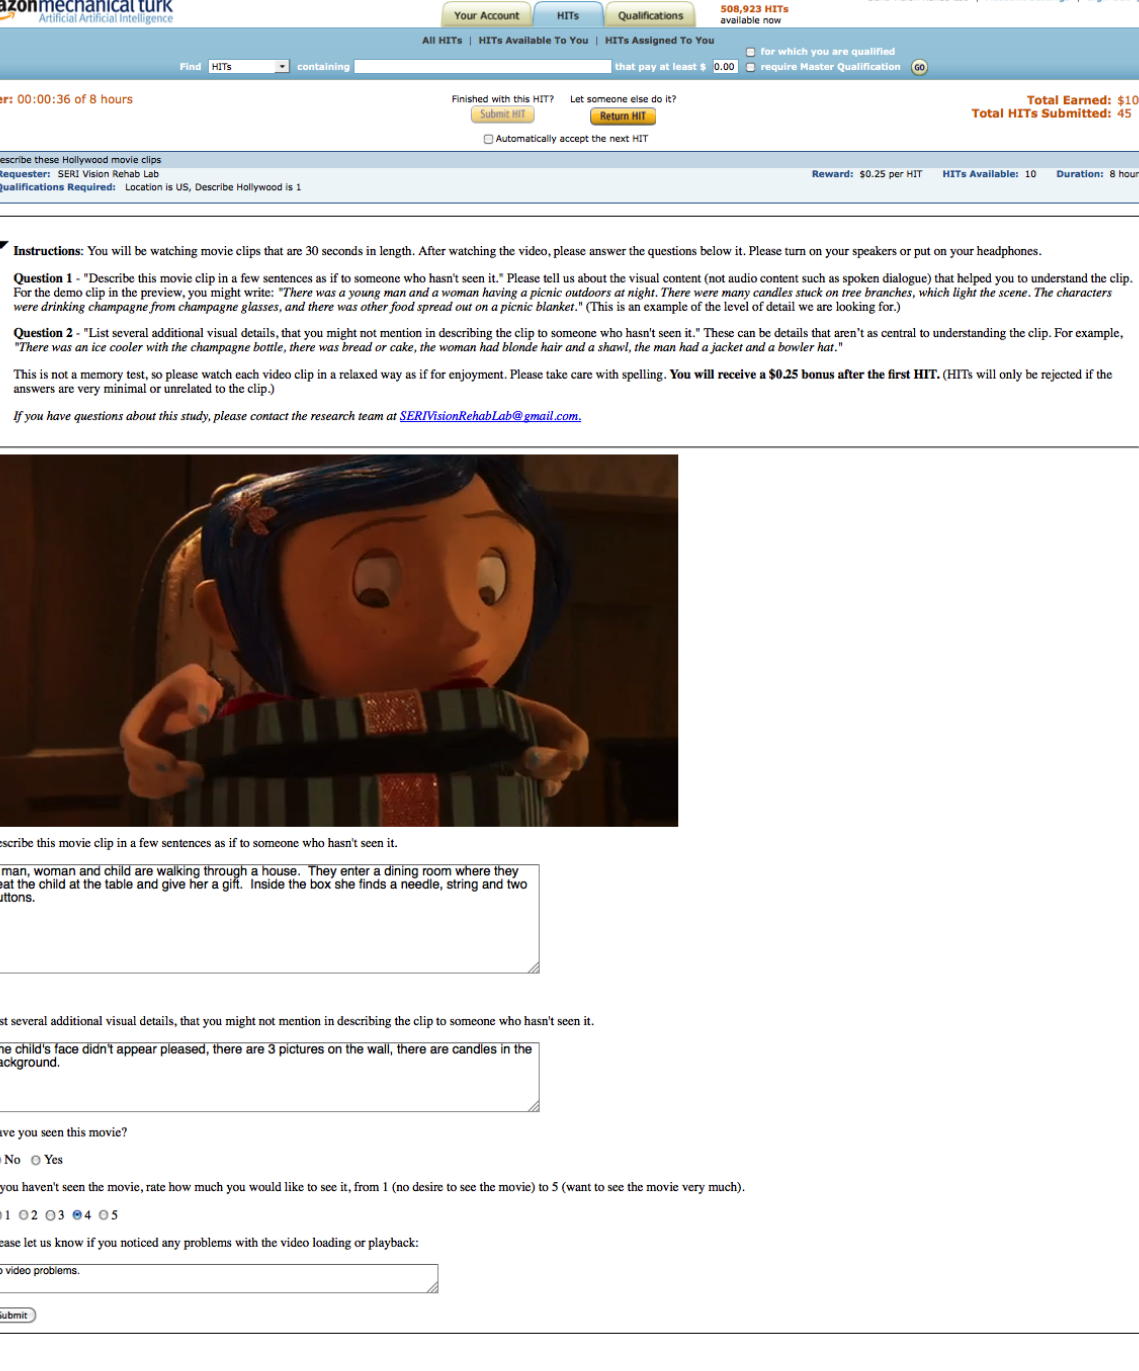
Figure 1. Example screenshot of Web forms used for data collection from crowdsourced participants, as hosted by Amazon Mechanical